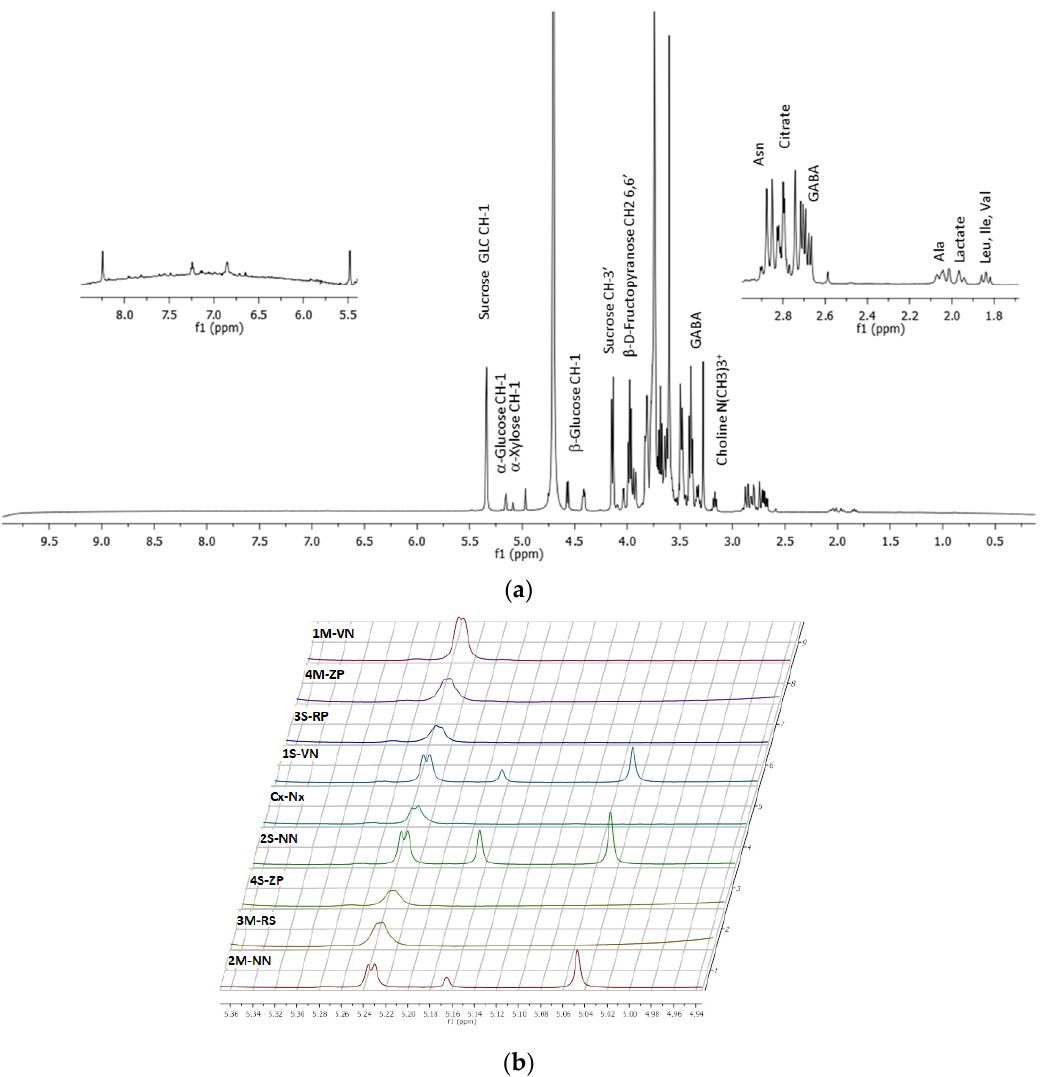
Figure 4. ( a ) 1 H-NMR spectrum of Sibari Area- Venus /Nectarine (sample 1S-VN) recorded at 600 MHz and 298 K. Two 1 H-NMR expansions in the ranges 5.5–8.5 ppm, and 1.5–3.0 ppm are also reported. ( b ) Staking plot of 1 H-NMR spectra of all the samples, in the region 4.70–5.60 ppm.